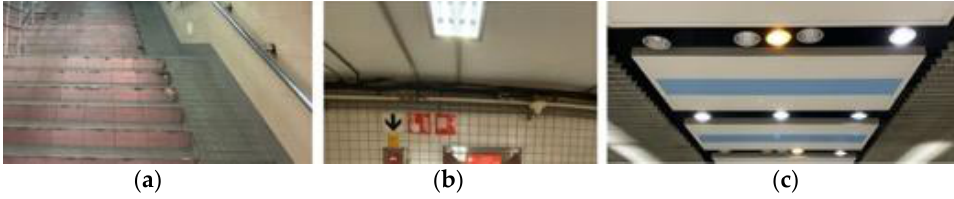
Figure 9. Safety status of transfer space environments at sample stations: ( a ) steps of wear; ( b ) pipeline exposure; ( c ) damaged lamps. Images courtesy of the author.